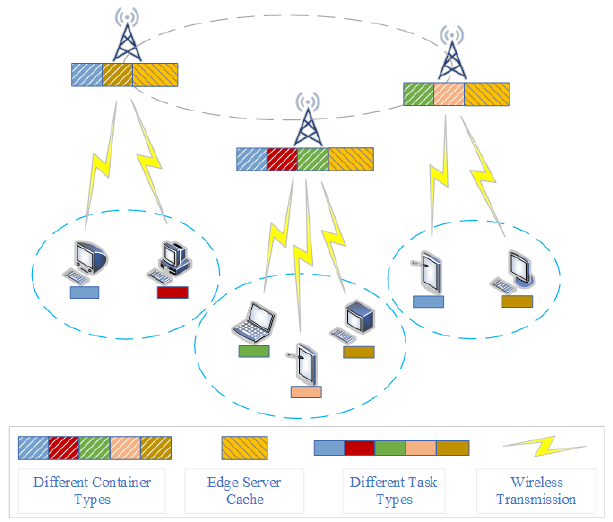
Figure 1. The multi-MD multi-container multi-server MEC